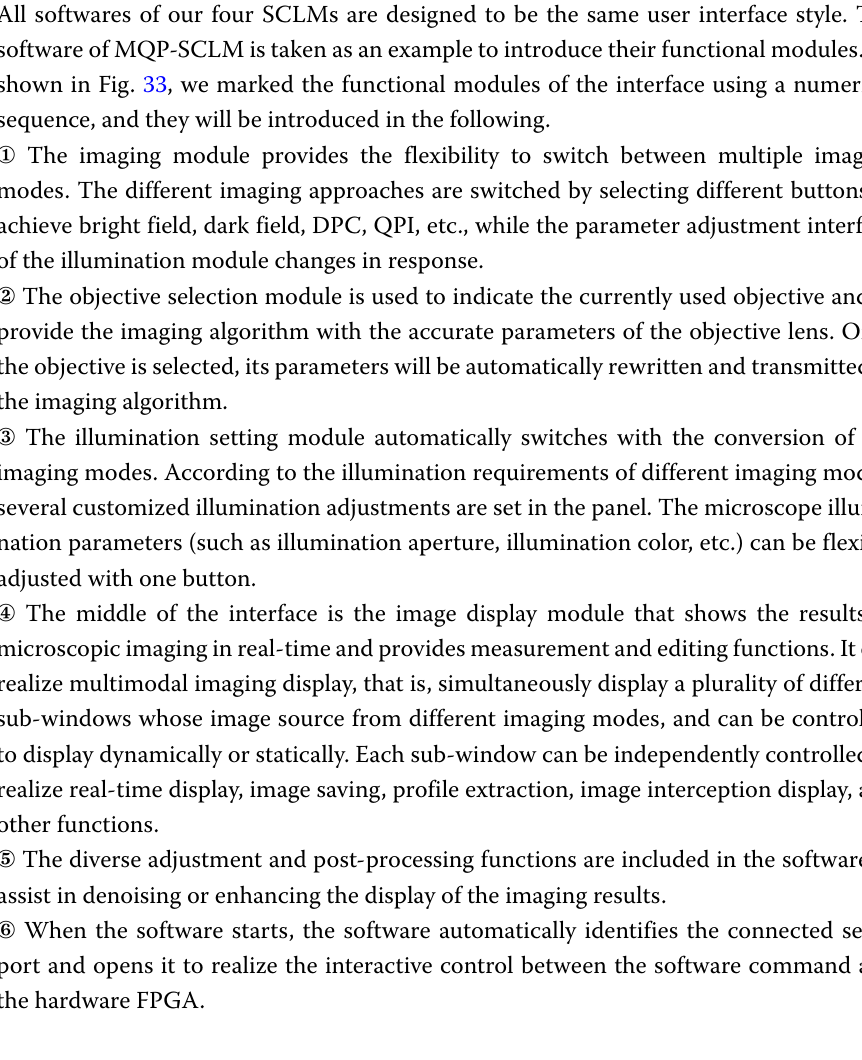
non-NVIDIA GPU devices, the software also uses Open Computing Language (OpenCL) to achieve parallel acceleration of the